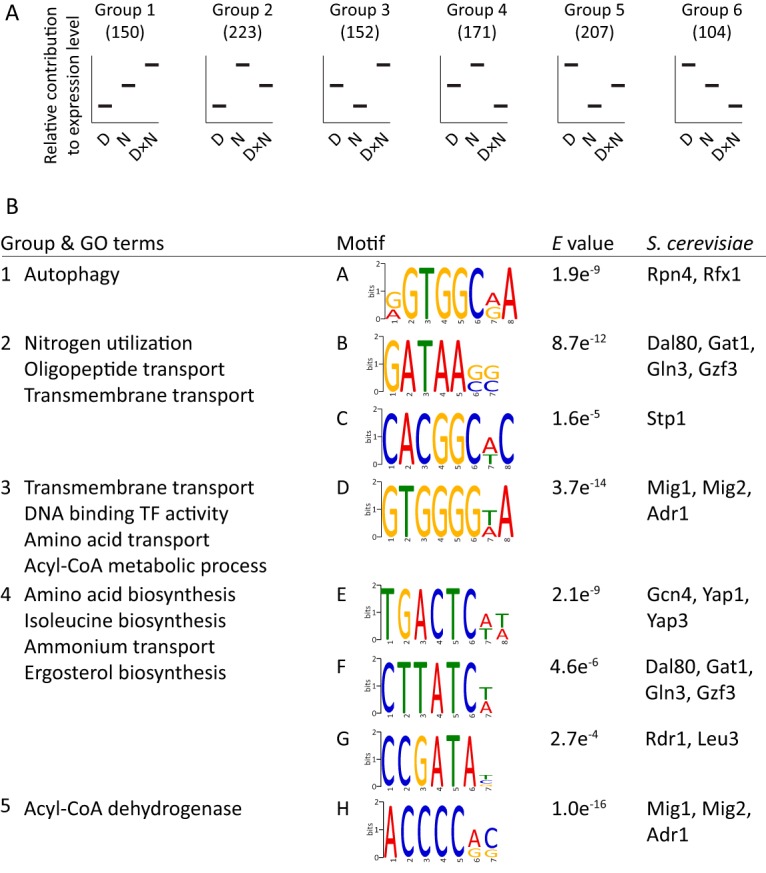
Enrichments of GO terms and transcription-factor binding motifs from genes with similar regulatory responses. (A) For each differentially expressed gene (adjusted P < 0.01), the relative contributions of the three factors (D, DGA1 overexpression; N, nitrogen limitation; D×N, interaction of DGA1 overexpression and nitrogen limitation) were ranked. The genes with the same order of factor contributions were subsequently clustered together (the number of genes per cluster is indicated). For example, for genes in group 4 (e.g., ILV3; see Fig. 1C), nitrogen limitation positively affects transcript levels, while D×N has a negative effect. DGA1 overexpression by itself has an effect that is between those of the other two factors. (B) For each cluster, (i) the GO term enrichment (redundant terms removed by manual curation) and (ii) the motifs found by DREME (15), their E value, and S. cerevisiae transcription factors with similar binding motifs, as identified with Tomtom (31), are indicated.